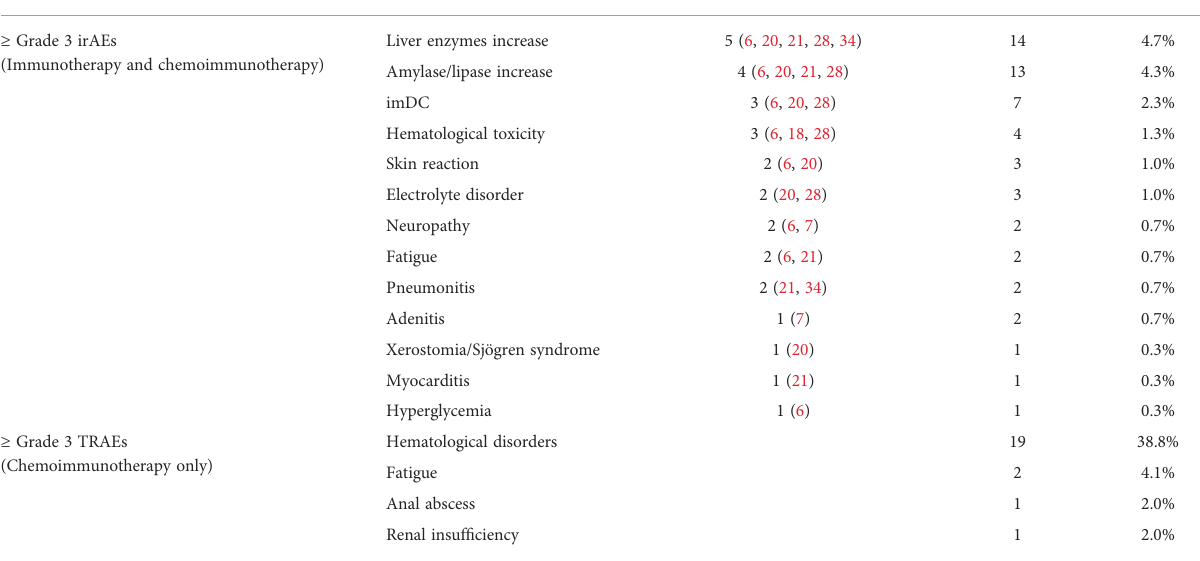
TABLE 3 AEs reported in included studies. .